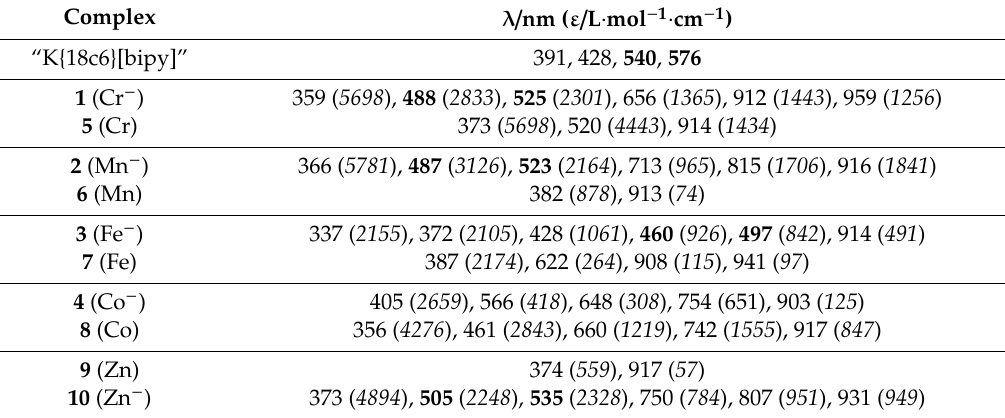
Table 4. UV / Vis spectroscopic features of complexes 1 – 10 in Et 2 O. Bold numbers highlight the two optical bands attributed to the π → π *-based transition of the reduced bipyridine ligand.